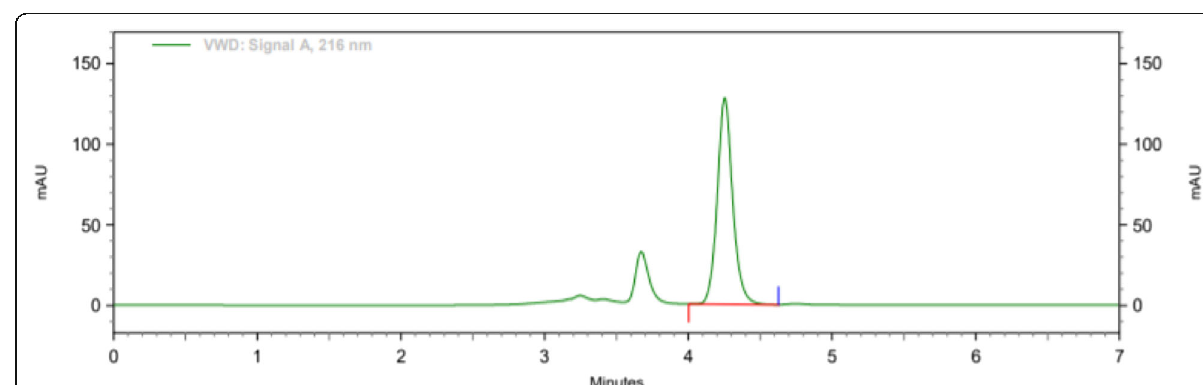
Fig. 8 Typical chromatogram of sample filtered through 0.45 μ PVDF filter